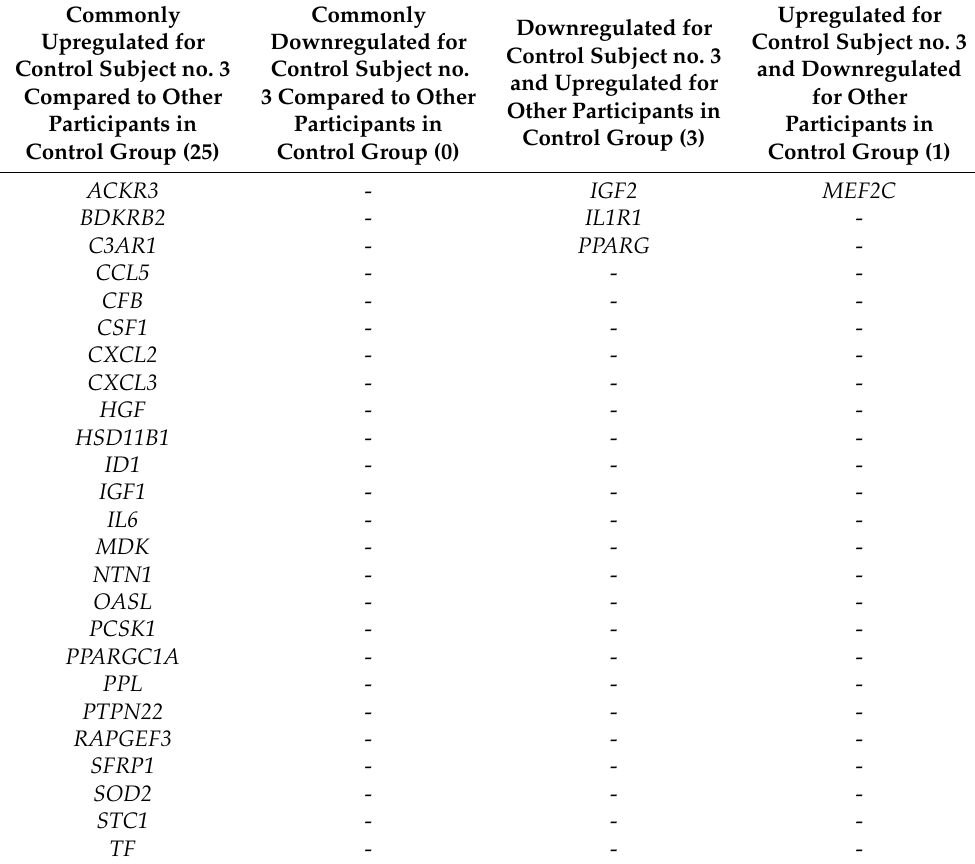
Table 3. Commonly upregulated or downregulated genes in mesenchymal stromal cells from partici- pants in the control